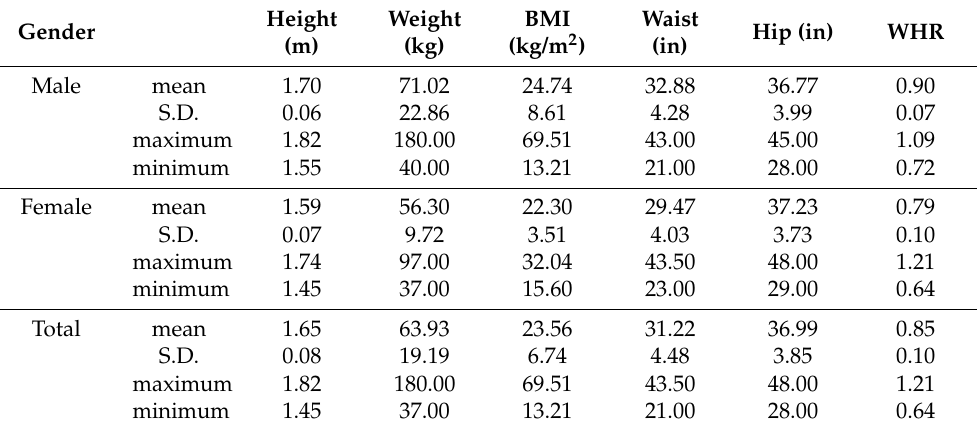
Table 2. The obesity indices of the participants, separated by